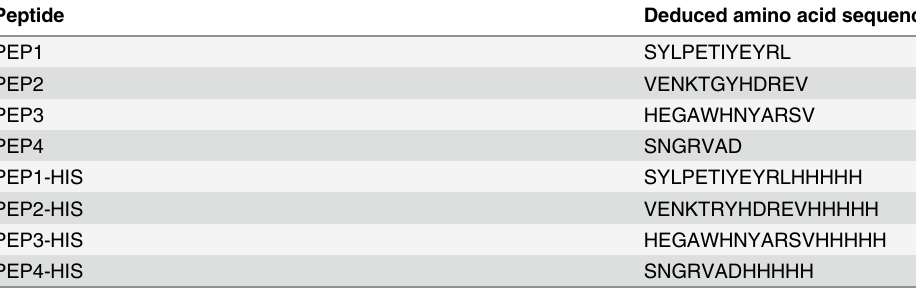
Table 5. Synthetic peptides used in determining FvTox1-neutralizing affect of displayed peptides in vitro